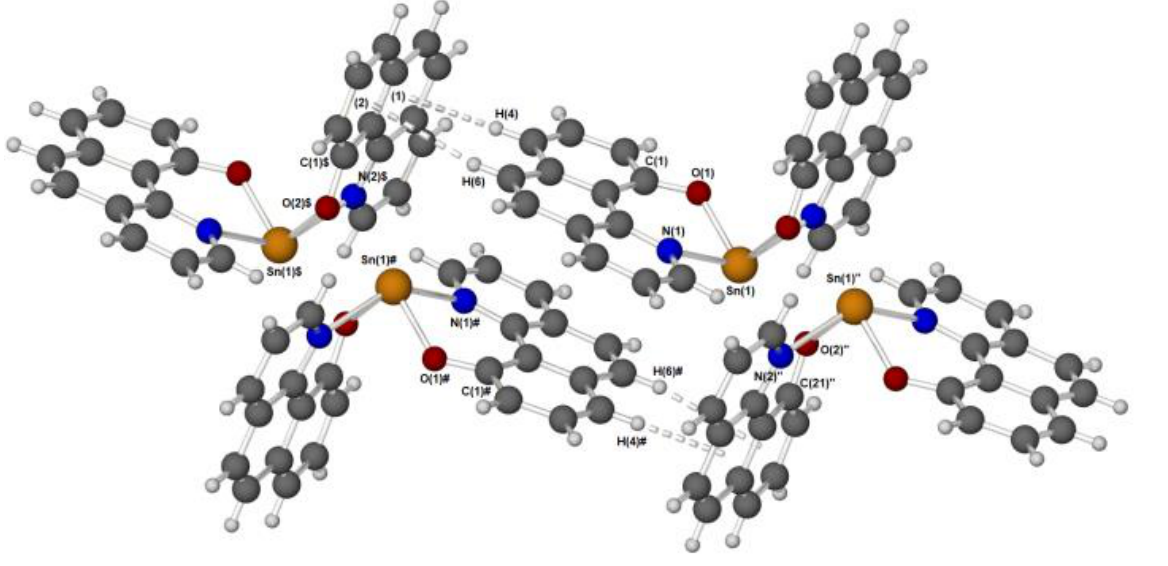
Figure 8. A representation of the H-Bonding and π - π stacking observed in the solid-state structure of 5 . Bond lengths: H(4)-(1) cent = 2.658(12) Å and H(6)-(2) cent = 3.227(12) Å. Inter-plane distance: {C(1)-N(1)}/{C(1)#-CN(1)#} = 3.687(12) Å. Symmetry transformations used to generate equivalent atoms: #1: X − 1, 1+Y, -Z; $#: X − 1, 1+Y, Z;”# X − 1, 1+Y, Z.